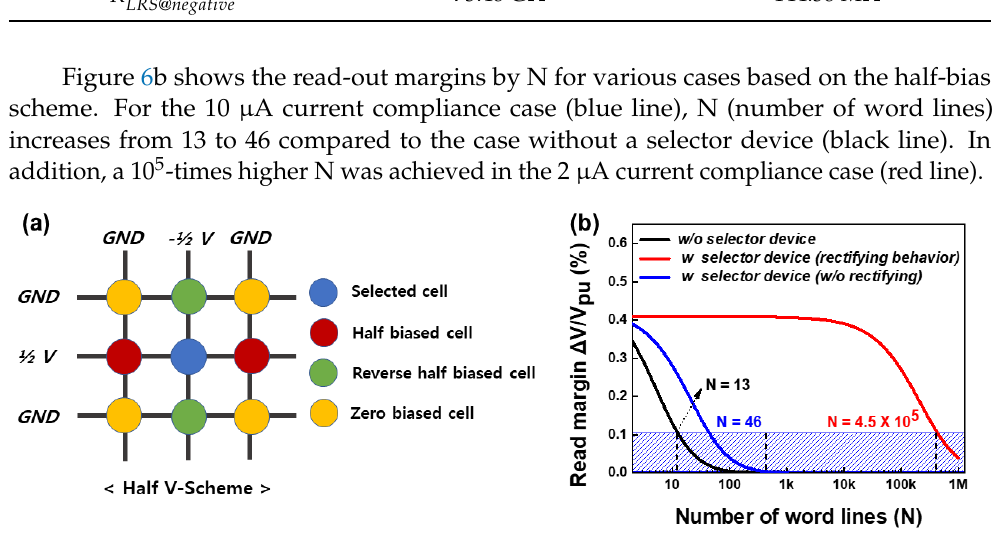
Figure 6. ( a ) Schematic of the half-bias scheme in the crossbar array. ( b ) Calculated read-out margins for various cases such as without the selector device, with the selector device, and with the rectifying selector device. The rectifying selector device exhibited an array size of more than 10 5 × 10 5